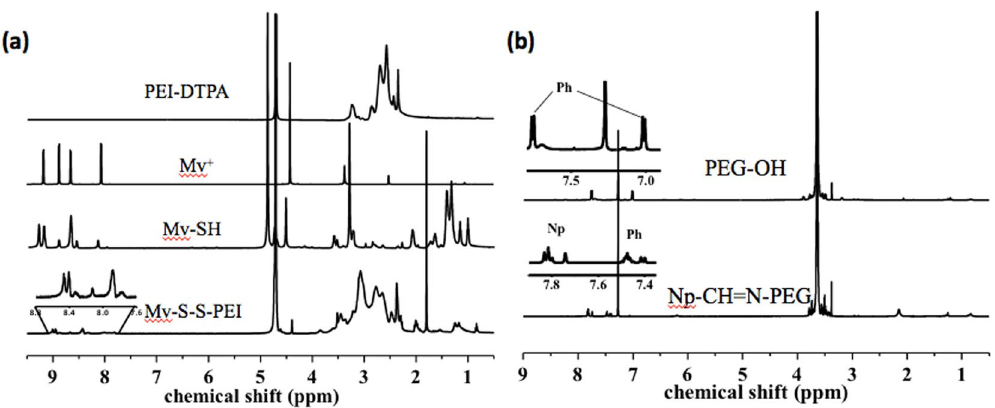
Figure 2. ( a ) 1 H NMR spectra of Mv-S-S-PEI and corresponding products in corresponding deuterium reagent; ( b ) 1 H NMR spectra of Np-CH = N-PEG and its corresponding product in CDCl 3